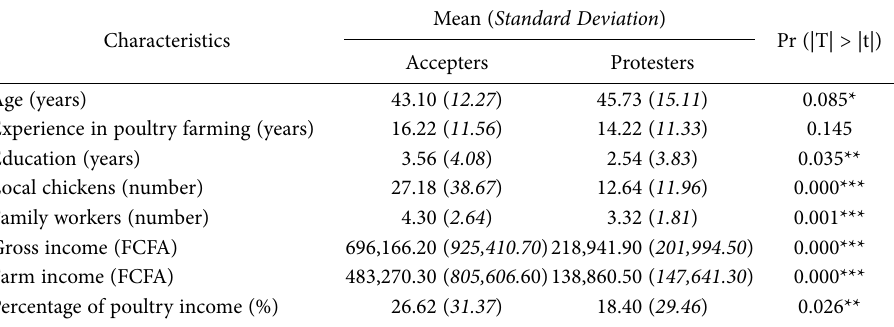
Table 3. Comparison of characteristics of accepters and protesters of payment vehicle.